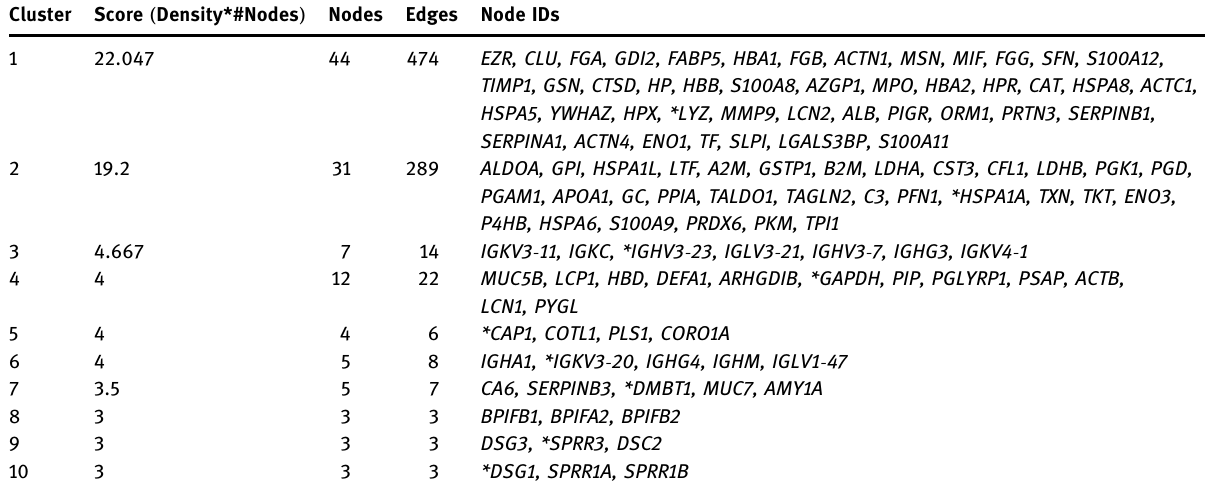
Table 6: Clusters generated from DEGs network using the Molecular Complex Detection ( MCODE ) plug - in in Cytoscape Cluster Score ( Density*#Nodes ) Nodes Edges Node IDs